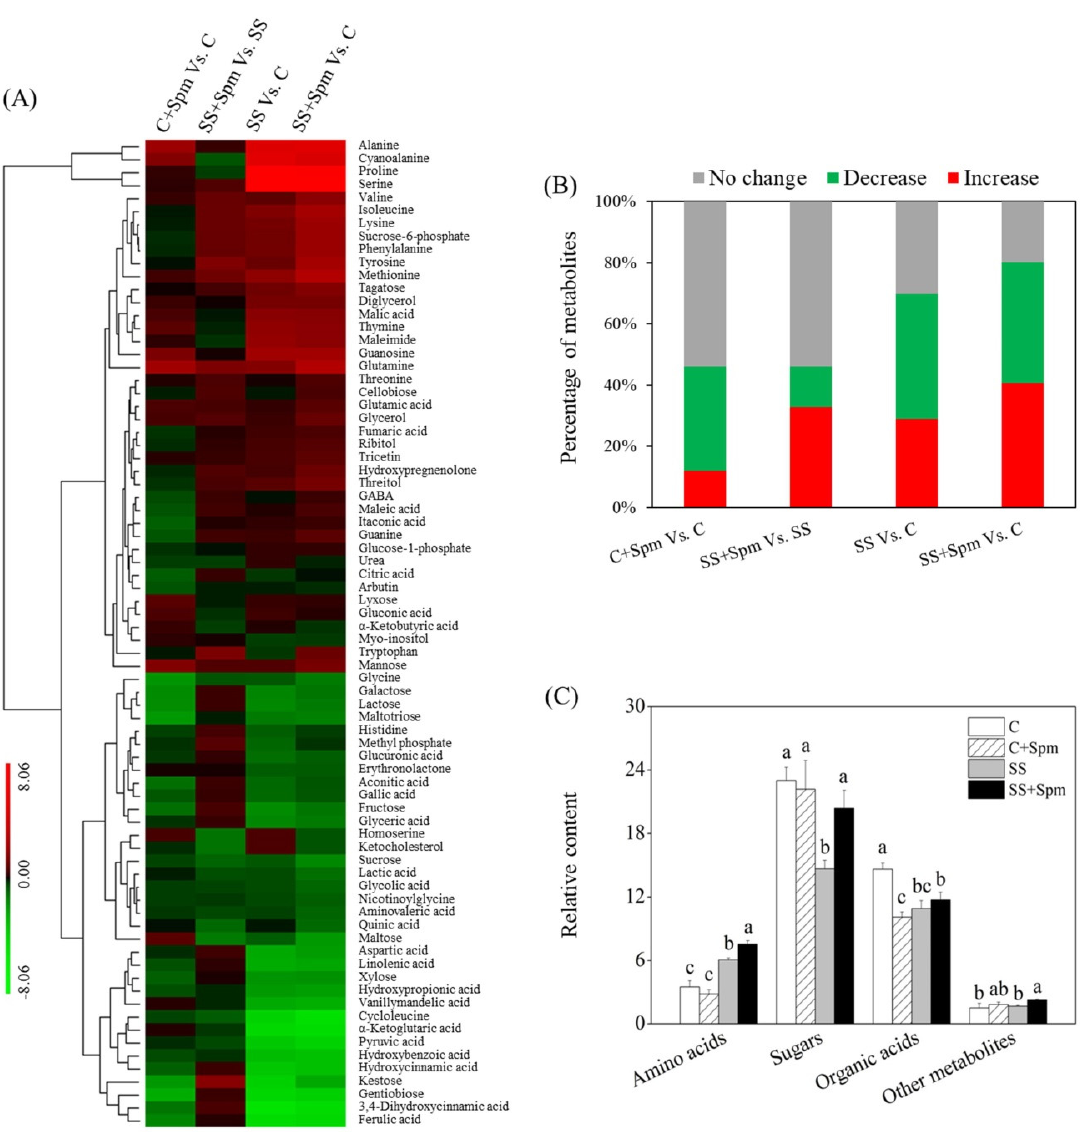
Figure 5. Changes in ( A ) heat map of all identified 76 metabolites, ( B ) percentage of up-regulated, down-regulated, and unchanged metabolites, and ( C ) relative content of amino acids, sugars, organic acids, and other metabolites in response to the Spm application and salt stress. Vertical bars indicate ±SE of mean (n = 4). Different letters above columns indicate significant differences based on LSD ( p < 0.05). C, control; C + Spm, control + Spm; SS, salt stress; SS + Spm, salt stress + Spm.